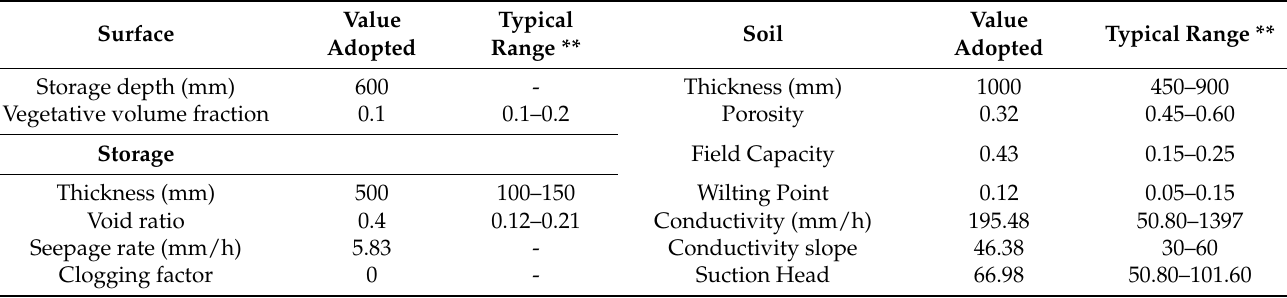
Table 3. Input data * for the bioretention cells modelled on